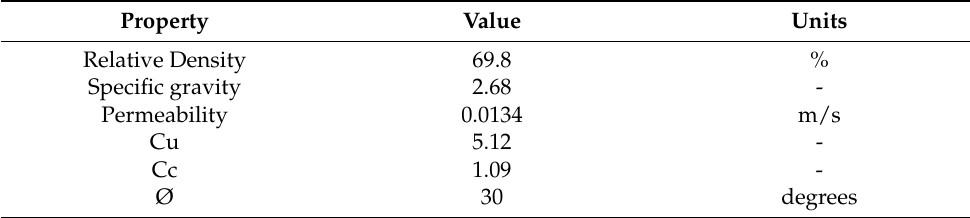
Table 3. Specifications of the sand used in the